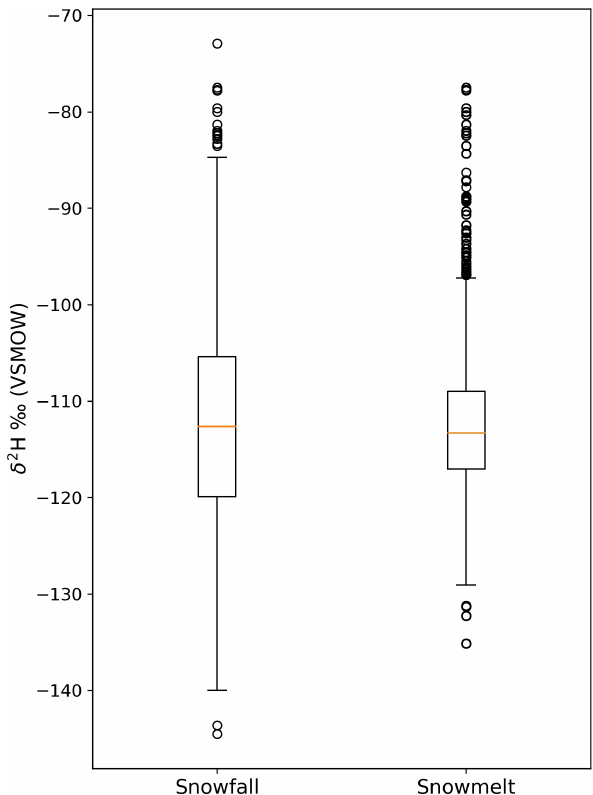
Figure 5. Box plot showing the variability in the isotopic ratio of snowfall and snowmelt as simulated by the hydrologic model. The box plot extends from the 25th to 75th percentile value, with the median value depicted by the orange line. The whiskers extend up to 1.5 times the interquartile range. The black circles are the